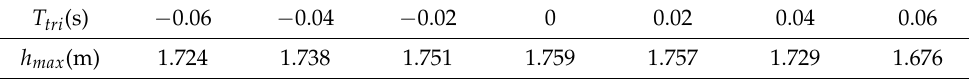
Table 3. The maximum height of torso with different trigger